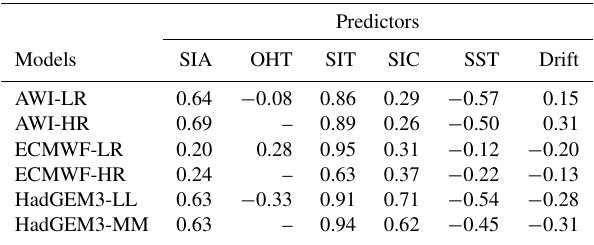
Table 1. Lag-0 correlation coefficient estimated between the pre- dictand (SIV anomaly) and a set of pan-Arctic potential predictors: SIA, OHT, SIT, SIC, SST, and Drift. The correlation coefficients between OHT and SIV anomaly for the high-resolution model ver- sions are not shown since only statistically significant coefficients are displayed in the table. Regional predictors (SIT, SIC, SST, and Drift) are represented by pan-Arctic averages. As for the predictand, all predictors are used with monthly time resolution and in terms of their